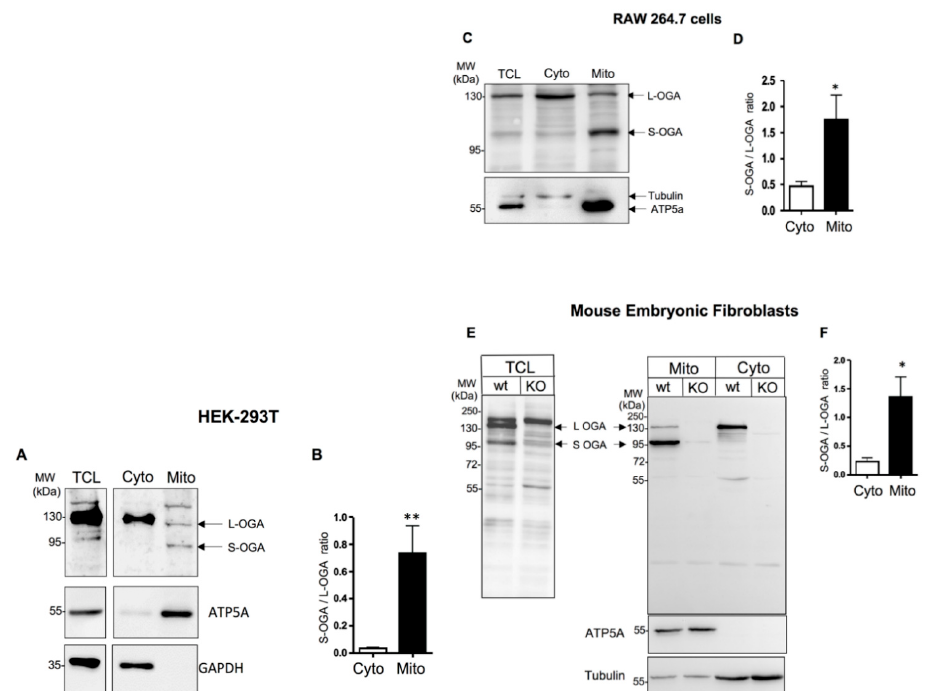
Figure 1. Detection of long and short OGA isoforms in HEK-293T cells and mouse embryonic fibro- blasts (MEF). ( A ) Detection of endogenous S-OGA ( ∼ 95 kDa) and L-OGA ( ∼ 130 kDa) bands in total cell lysates (TCL), mitochondrial-enriched (Mito), and cytosolic-enriched (Cyto) fractions from HEK-293T cells by Western blotting with anti-OGA Novus antibody. Mitochondrial and cytosol fractions were controlled using anti-ATP5A and anti-GAPDH antibodies. The 95 kDa band was essentially recovered in the mitochondria-enriched fraction, whereas the 130 kDa band was mostly recovered in the cytosol- enriched fraction. ( B ) Densitometric analysis of the 95 kDa and 130 kDa OGA bands in HEK-293T cells. The results are the mean ± SEM of the ratio of the 95 kDa to the 130 kDa OGA bands detected in cytosol- and mitochondria-enriched fractions ( n = 9; **: p < 0.01). ( C ) Detection of endogenous S-OGA ( ∼ 95 kDa) and L-OGA ( ∼ 130 kDa) bands in total cell lysates (TCL), mitochondria-enriched (Mito), and cytosol-en- riched (Cyto) fractions from RAW 264.7 cells by Western blotting with anti-OGA Novus antibody. Mito- chondrial and cytosol fractions were controlled using anti-ATP5A and anti-tubulin antibodies. The 95 kDa band was predominant in the mitochondria-enriched fraction, whereas the 130 kDa band was pre- dominant in the cytosol-enriched fraction. ( D ) Densitometric analysis of the 95 kDa and 130 kDa OGA bands in RAW 264.7 cells. The results are the mean ± SEM of the ratio of the 95 kDa to the 130 kDa OGA bands detected in cytosol- and mitochondria-enriched fractions ( n = 8; *: p < 0.05). ( E ) Detection of endog- enous S-OGA ( ∼ 95 kDa) and L-OGA ( ∼ 130 kDa) bands in total cell lysates (TCL), mitochondria-enriched (Mito), and cytosol-enriched (Cyto) fractions from wild-type (wt) and OGA-KO mouse embryonic fibro- blasts (MEF) by Western blotting with anti-OGA Novus antibody. Mitochondrial and cytosol fractions were controlled using anti-ATP5A and anti-tubulin antibodies. The 95 kDa band was predominant in the mitochondria-enriched fraction of wt-MEF, whereas the 130 kDa band was predominant in the cytosol- enriched fraction of wt-MEF. Both bands were absent in the corresponding fractions in OGA-KO MEF. An additional band (about 180 kDa) was also detected in total cell lysates, but this band was present in both wt and OGA-KO MEF, indicating that it corresponded to an unrelated protein. ( F ) Densitometric analysis of the 95 kDa and 130 kDa OGA bands in wt-MEF. The results are the mean ± SEM of the ratio of the 95 kDa to 130 kDa OGA signals detected in cytosol- and mitochondria-enriched fractions ( n = 6; *: p < 0.05).